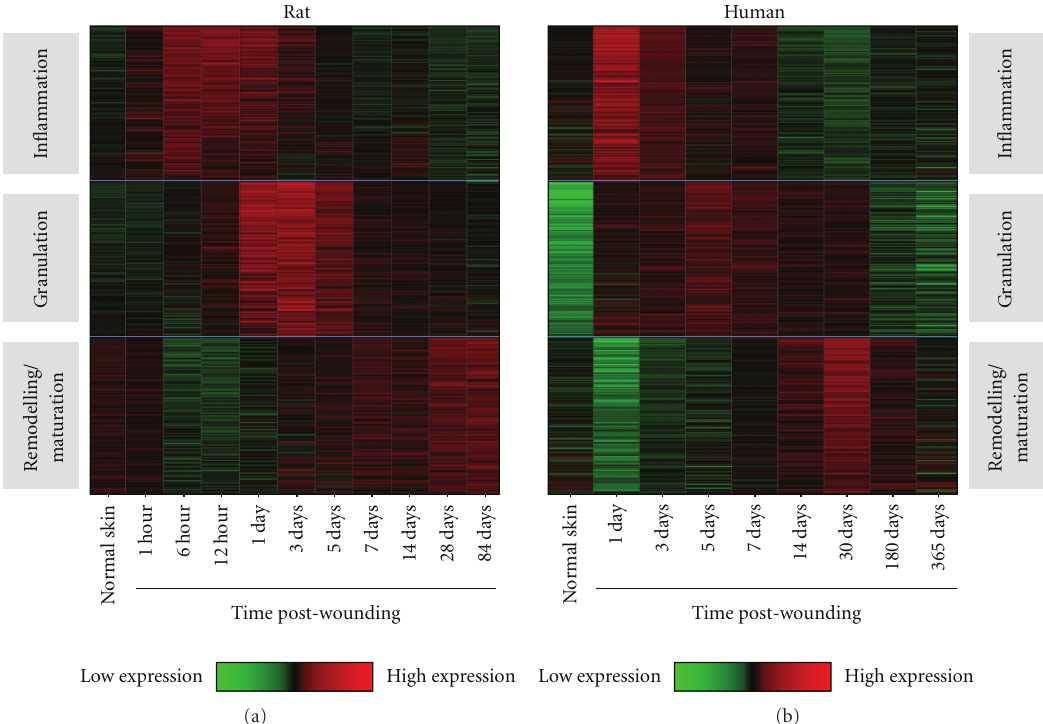
Figure 4: Gene expression in models of incisional wounds and scars in rat and man demonstrate molecular comparability heatmaps of samples of normal skin, wounds, and scars following 1cm incisional wounds analysed for gene expression using A ff ymetrix Microarrays comparing the levels and timings of expression of genes involved in the inflammatory, granulation, remodelling, and maturation phases of healing and scarring (examples shown consist of comparison of ∼ 300 genes for each